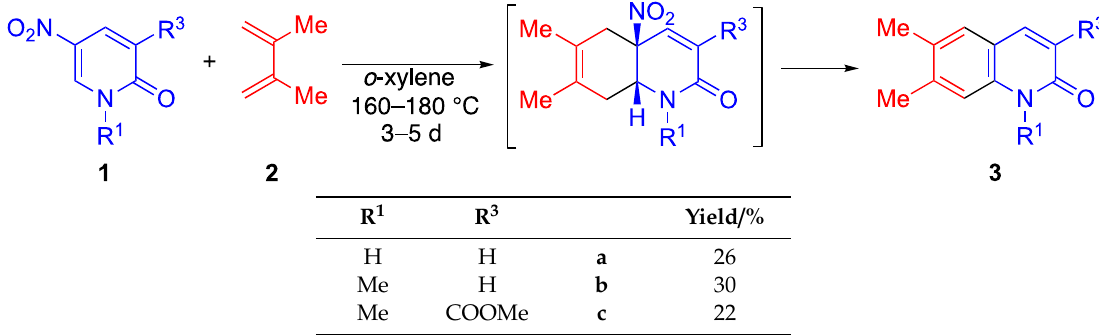
Table 1. D-A cycloaddition of 5-nitropyridones 1 with diene 2 .